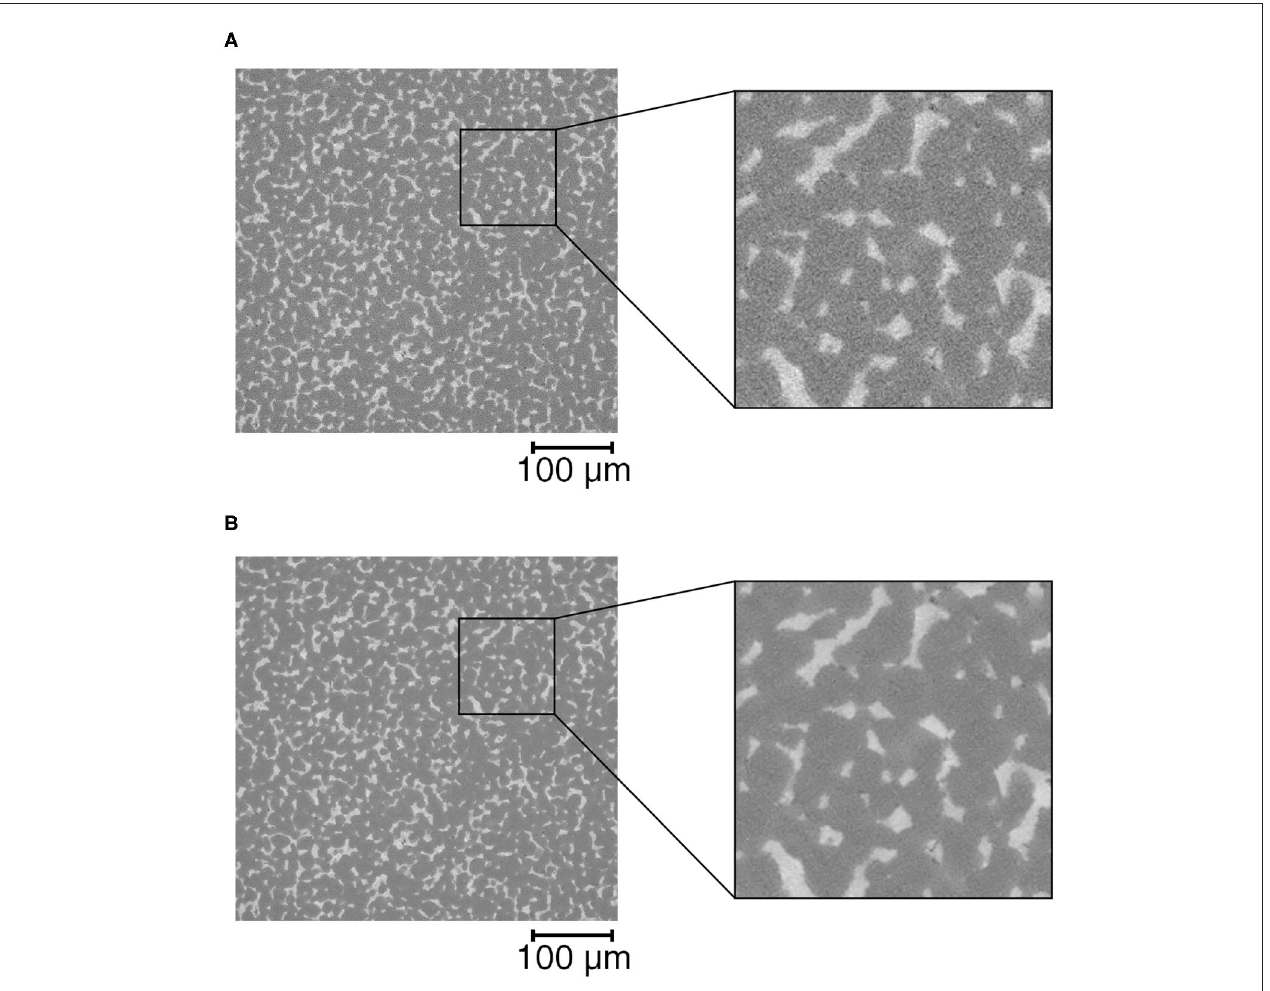
FIGURE 1 | Before and after filtering of images using non-local means algorithm. Panel (A) shows a raw 2D slice through the whole sample OFS-5, with inset showing the pixelated texture present in raw data. Panel (B) shows the same 2D slice following the image filtering. The inset shows the improved quality of the image with effective smoothing of different